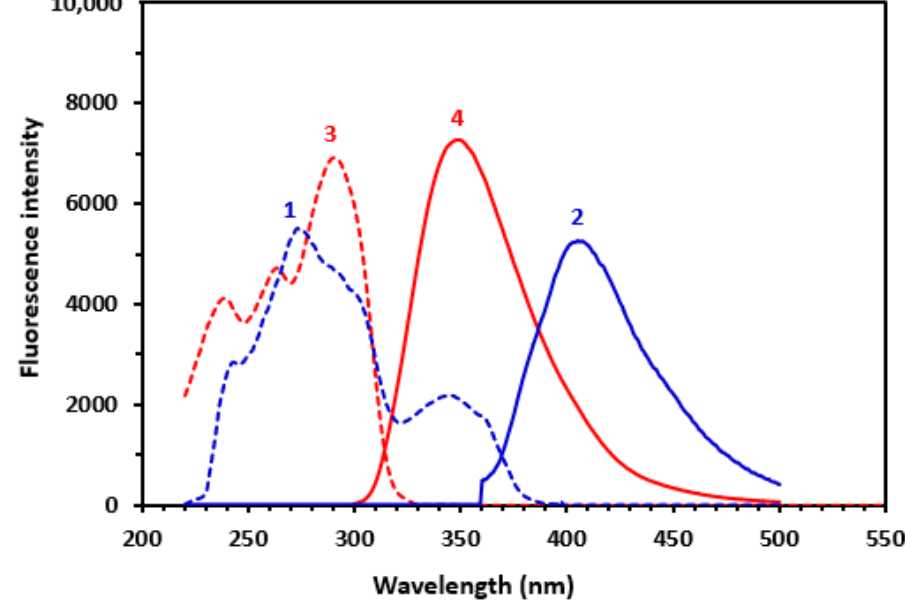
Figure 9. The fluorescence (excitation and emission) spectra of DUV (1 and 2, respectively) and SEL (3 and 4, respectively). The concentrations of DUV and SEL were 380 and 10 μg/mL, respectively. Both solutions were in methanol.